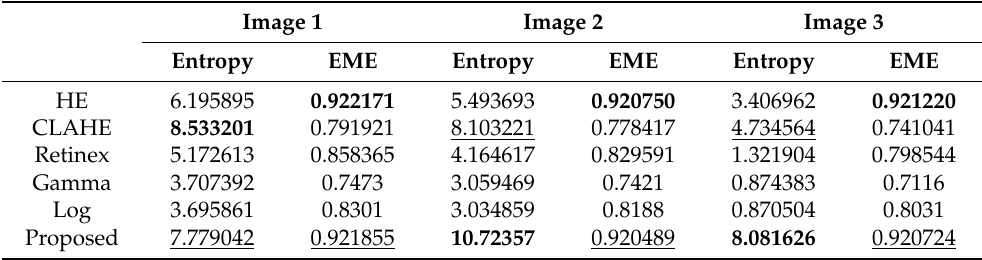
Table 2. Numerical results on real SAR images. The highest and second-highest scores are marked in bold and underlined respectively.